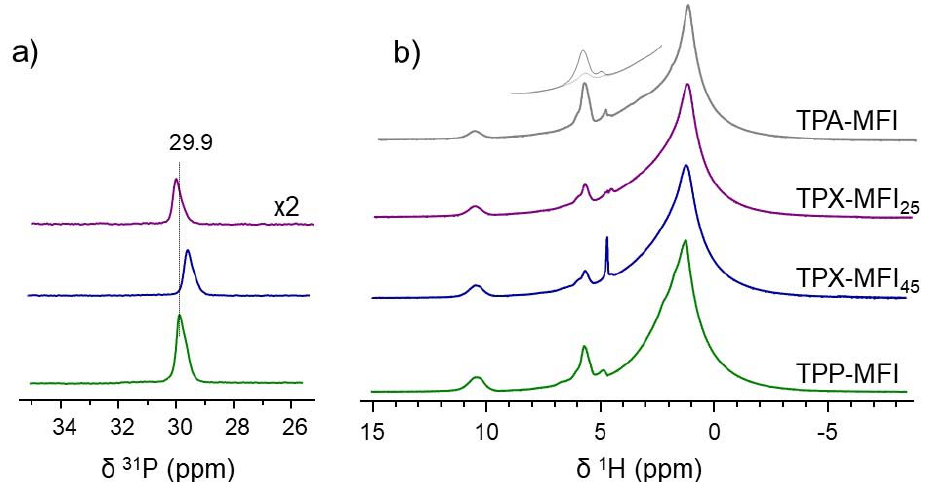
Figure 6. 31 P and 1 H MAS NMR spectra of silicalite-1 samples synthesized using different OSDAs: ( a ) 31 P MAS NMR spectra of the zeolites prepared using TPP and TPP/TPA mixtures; ( b ) 1 H MAS NMR spectra of the zeolites prepared using TPP, TPA, and mixtures of them. Amplification corresponds to the evacuation of the TPA-MFI sample in the NMR rotor under mild conditions (100 °C, 10 h).